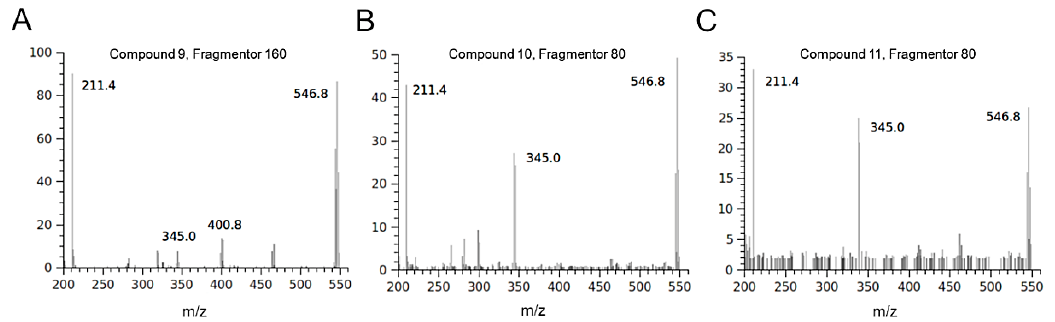
Figure 3. Mass spectra of isobaric halogenophenols detected in HIE/n recorded in negative ionization mode. The compounds showed a different fragmentation pattern depending on the applied energy: 160 V for compound 9 ( A ) and 80 V for compounds 10 ( B ) and 11 ( C ).